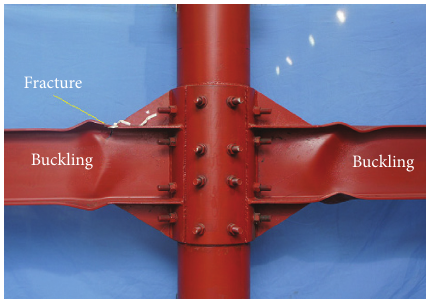
Figure 8: Failure modes of